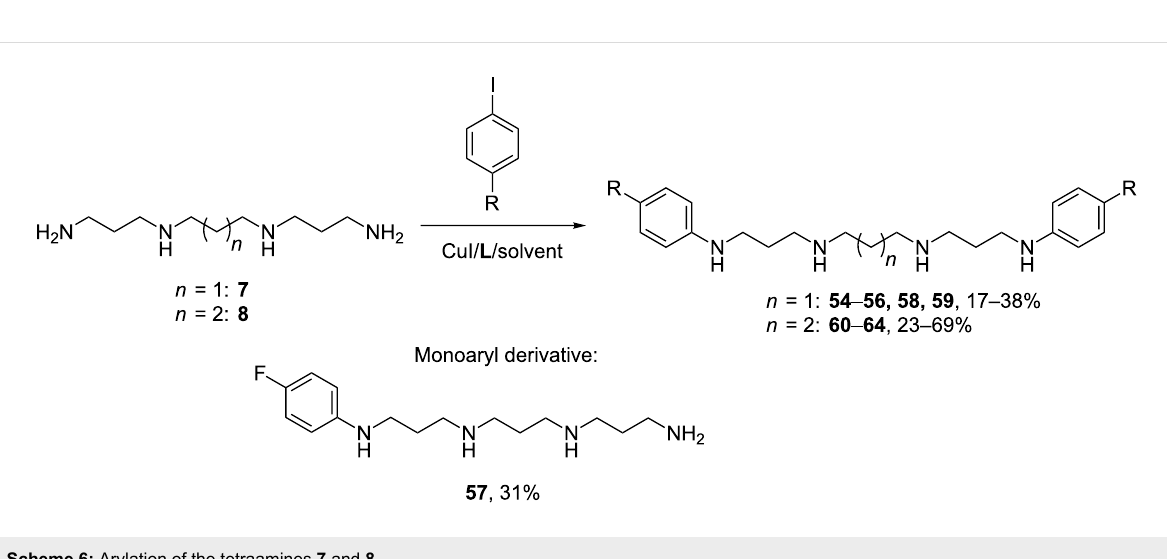
Scheme 6: Arylation of the tetraamines 7 and 8